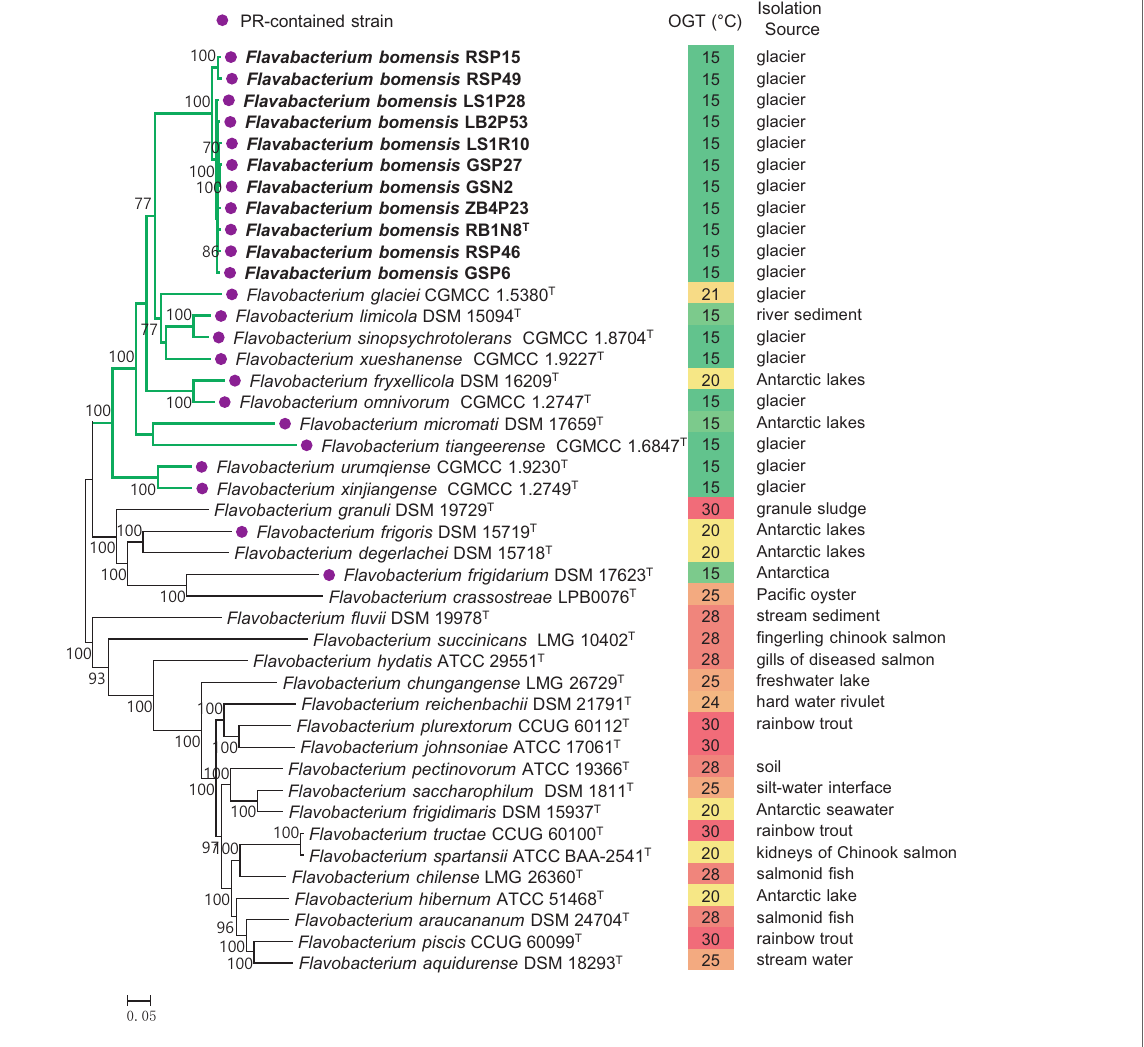
FIGURE 1 | Phylogeny of the new strains and related species constructed from an ML analysis of the 230 concatenated single-copy gene sequences. Bootstrap values ≥70% based on 1,000 replicates are indicated at branch points. Bar = 0.05 nt substitutions per site. PR, proteorhodopsin; OGT, optimal growth